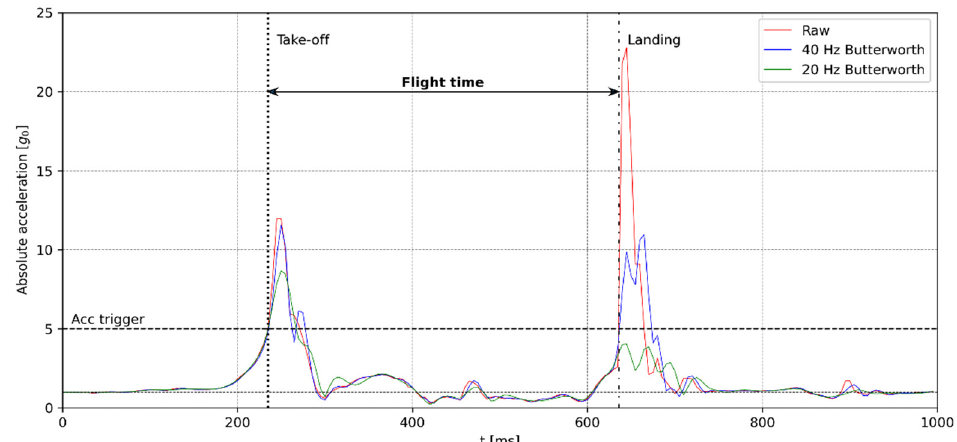
Figure 2. Flight time with the effect of different signal filters with detected events and optimal trigger.